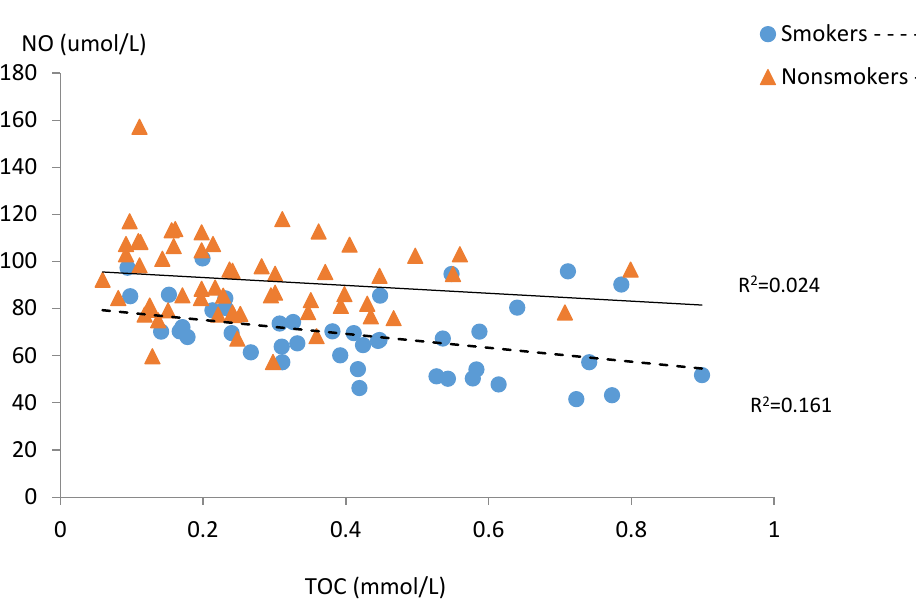
Figure 2. Correlations between serum NO and TOC levels in the subgroups of smoking (n = 42) and non-smoking pregnant women (n = 57). Serum concentration of NO slightly correlated negatively with the OSI value in smoking and non-smoking mothers, but it was on the border of statistical significance (Figure 3).